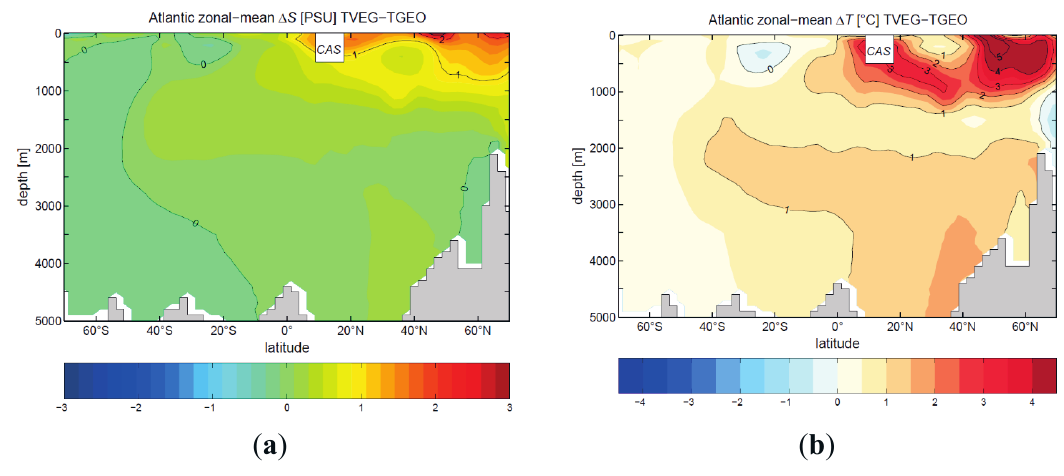
Figure 12. Zonal mean difference between TVEG and TGEO in the Atlantic Ocean: ( a ) salinity; ( b )